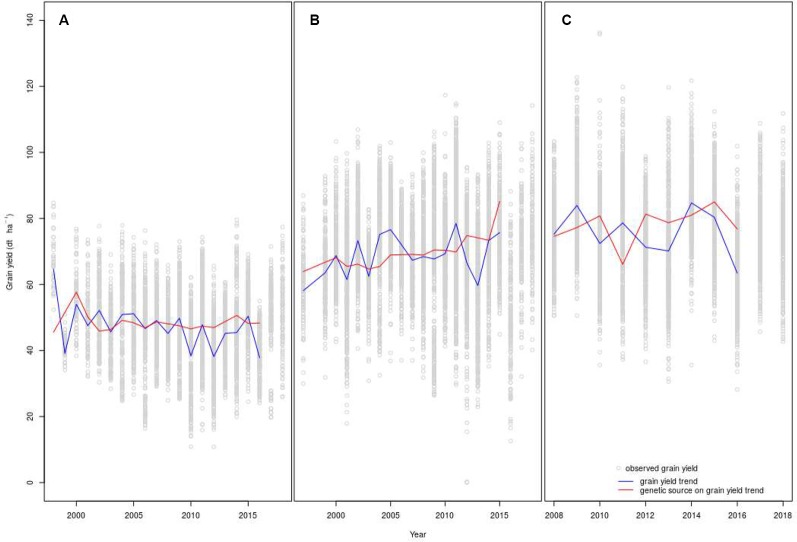
Grain yield trends and genetic sources on the grain yield trends under organic (A), conventional low-inputs (B), and conventional high-inputs (C) management. The fit on the models is shown until 2016 because the analysis was performed on genotypes that remained in the trials at least three years. Because of this criterion, the year 2016 was the last year available to consider the year that a genotype entered the variety trials. X-axis of panels (A–C) have different scales.